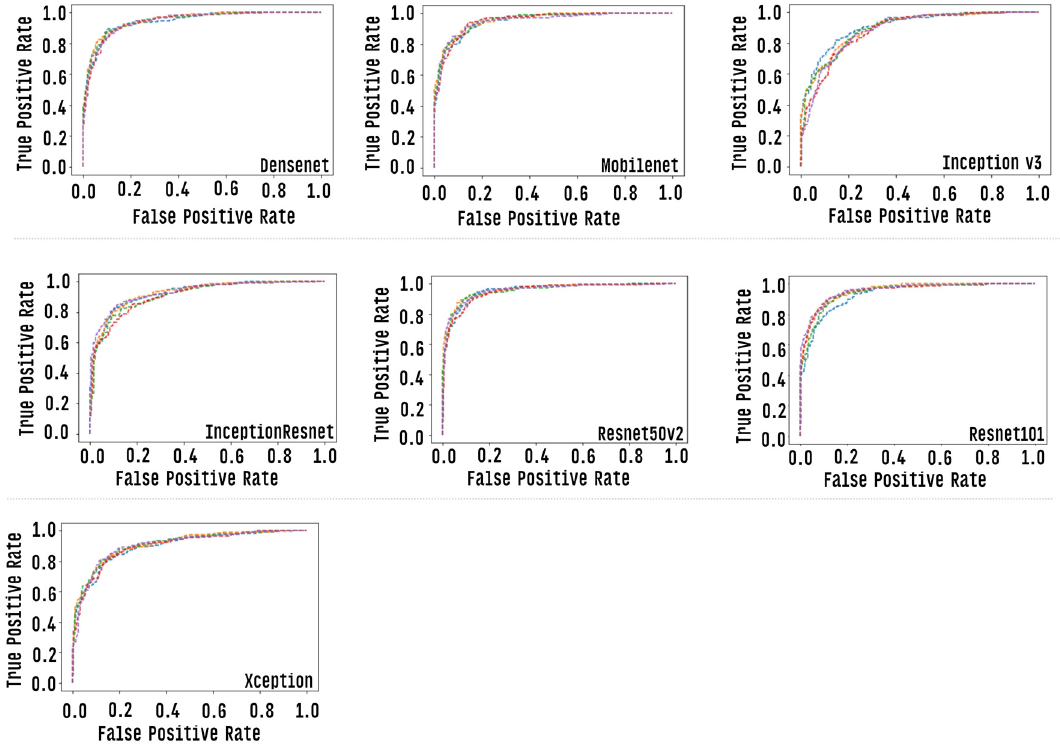
Figure 11. Roc curve of each of the individual CNN models, each row corresponds to one round of cross-validation.